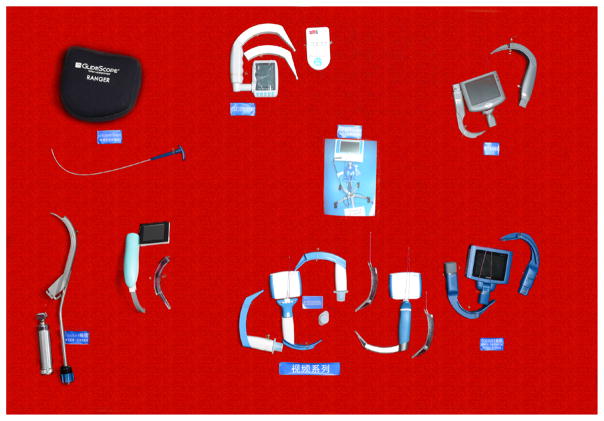
Video laryngoscope.